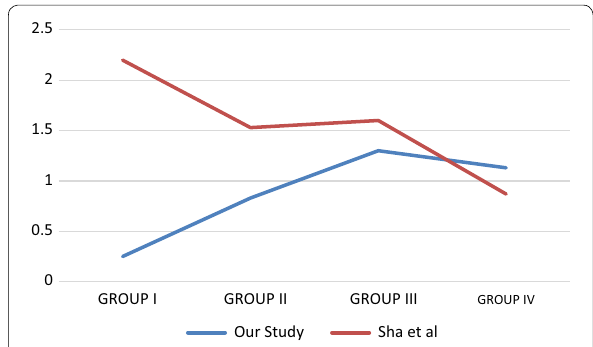
Fig. 3 Comparison of number of mechanoreceptors over a graded time period for our study versus that of Sha et al.